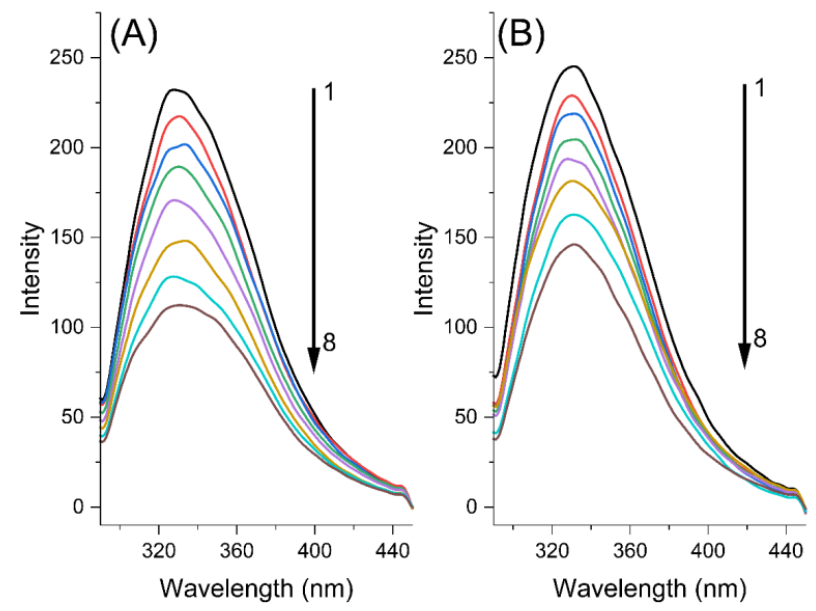
Figure 2. Fluorescence emission spectra of 3.46 µ M PK at pH 8.0, in the presence of different concentrations of MYR ( A ) and MYT ( B ), respectively, at 300 K. From 1 to 8, the concentrations of MYR and MYT were 0.0, 2.5, 5.0, 7.0, 10.0, 15.0, 20.0, and 25.0 µ M, respectively.